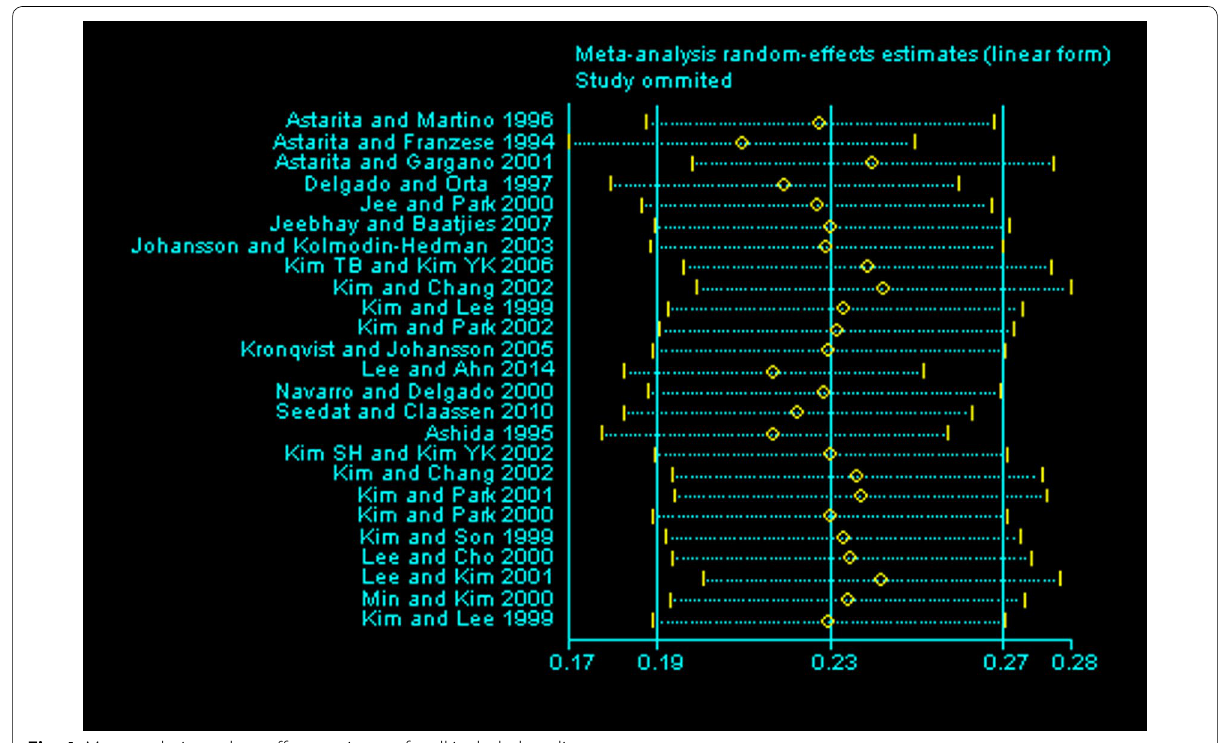
Fig. 4 Meta-analysis random-effects estimates for all included